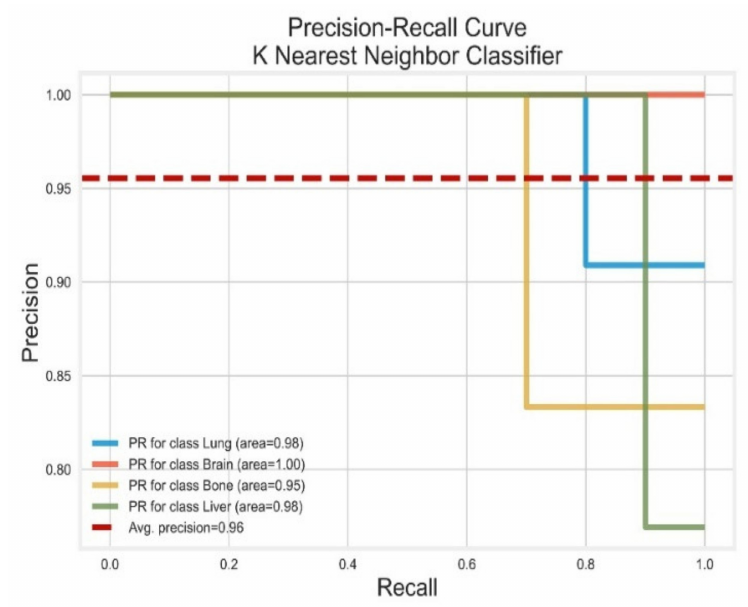
Figure 23. Precision-Recall Curve (K Nearest Neighbor Classifier).